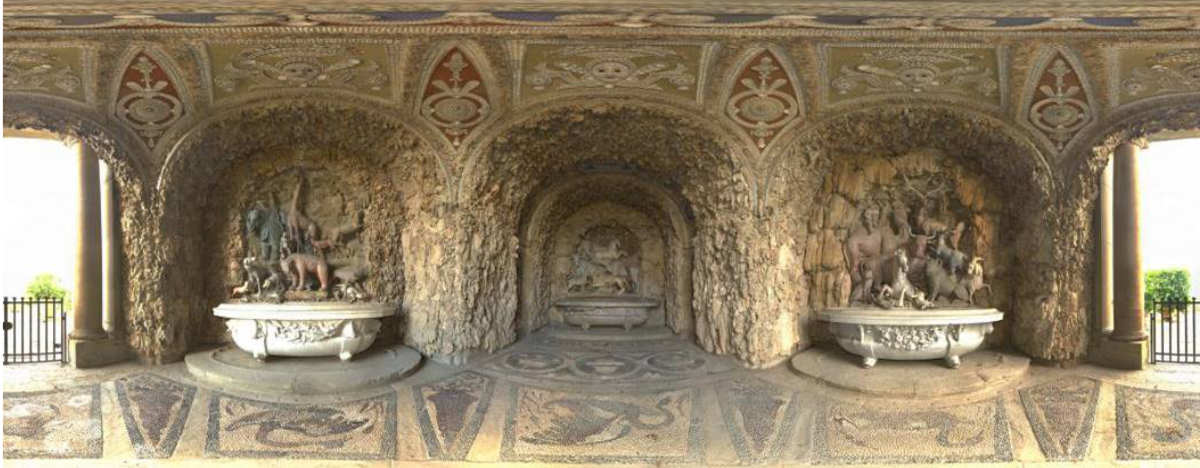
Figure 1. The Grotto of Animals. Panoramic